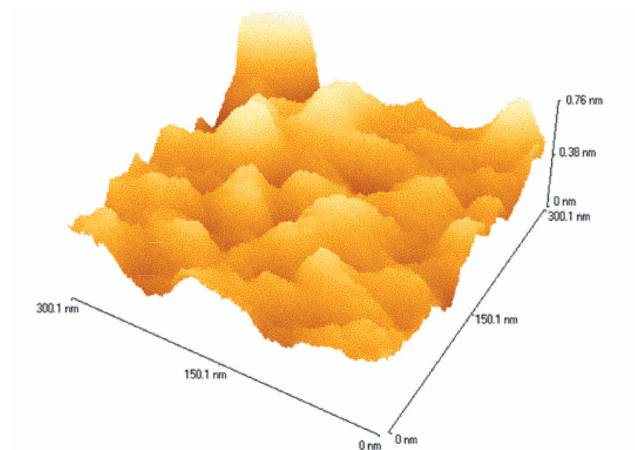
Figure 2 An image of the smooth sample obtained with an atomic force microscope.